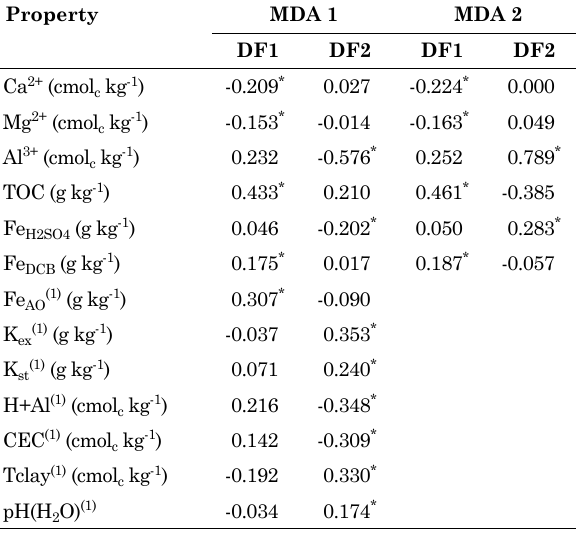
Table 5. Structure matrix coefficients of the soil chemical properties discriminant models